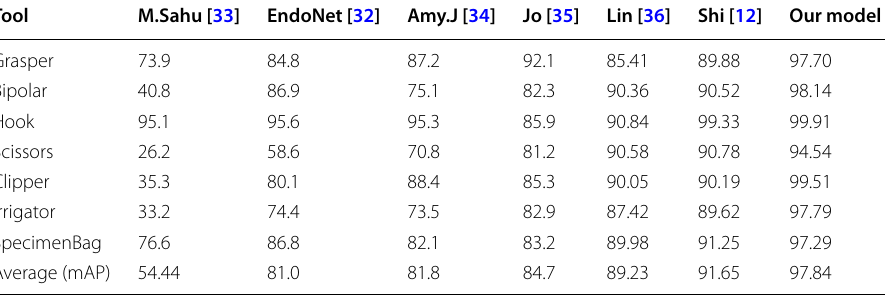
Table 3 Comparison of the average precision (AP) for all tools with other models